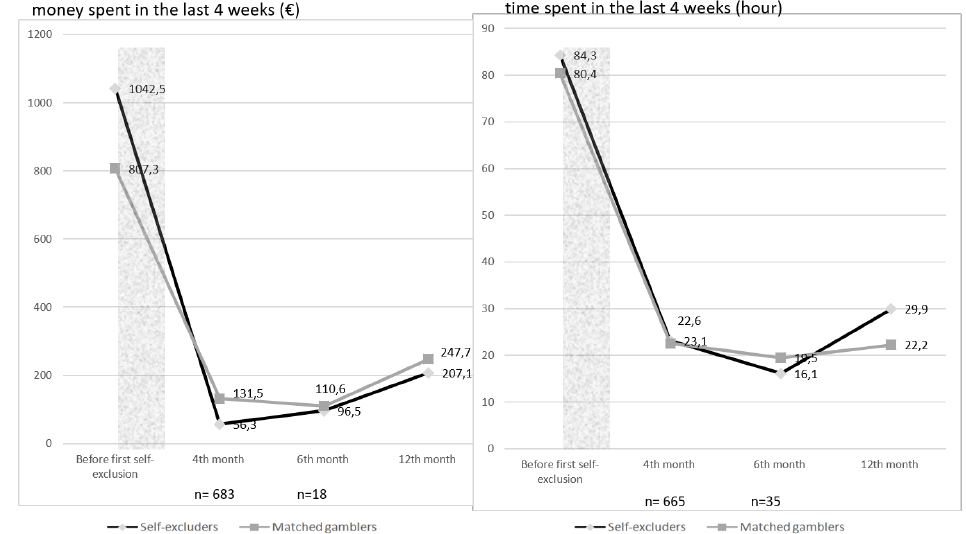
Figure 4. Evolution of money spent (net loss) in the last 4 weeks before and after a short self-exclusion among the gamblers who were the most heavily involved in terms of money ( n = 683 and 18 respectively for the self-excluders and the control group of matched gamblers) and in terms of time ( n = 665 and 35 respectively for the self-excluders and the control group of matched gamblers). (* = p -value < 0.05—ANOVA between the mixed model with and the null model without the interaction of self-exclusion X